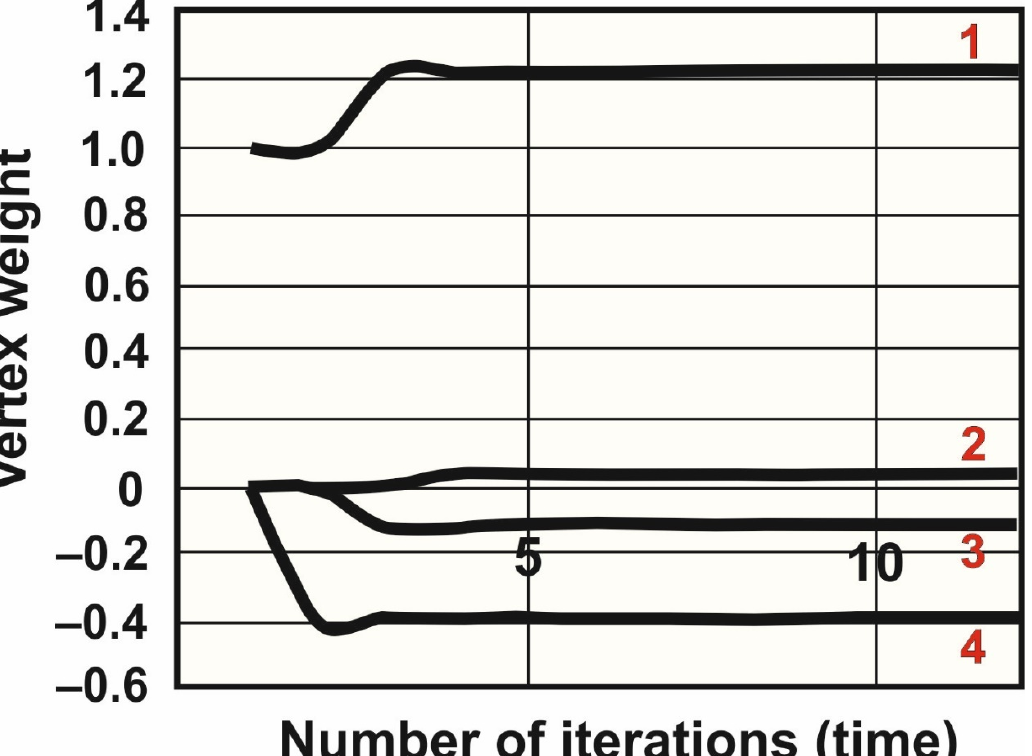
Figure 6. Accumulation of plant community weights for a sustainable SVC of arid ecosystems. 1—initial pastures, 2—community of wormwoods; 3—community of annual weed species, 4—open sands.